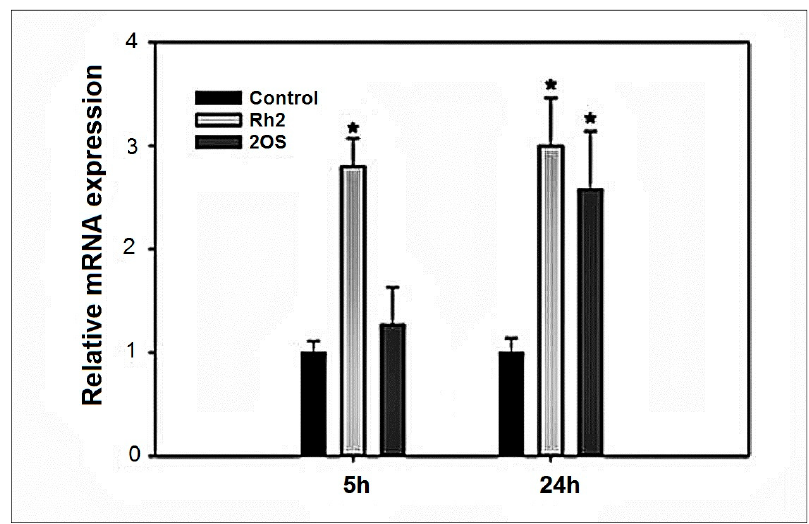
Figure 8. Real-time PCR for HMOX1 expression. HMOX1 expression upon treatment with 25 μ M Rh2 and 20S-protopanaxadiol at 5 h and 24 h incubation. Results shown as mean ± SEM ( n = 3). * p < 0.05 versus control.